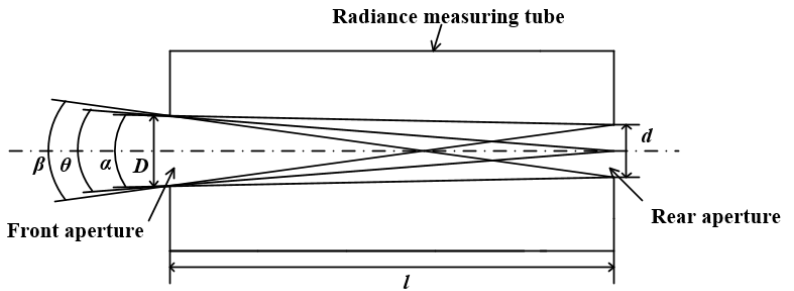
Figure 2. Schematic of FOV. Table 1. Viewing angles of the transfer radiometer.